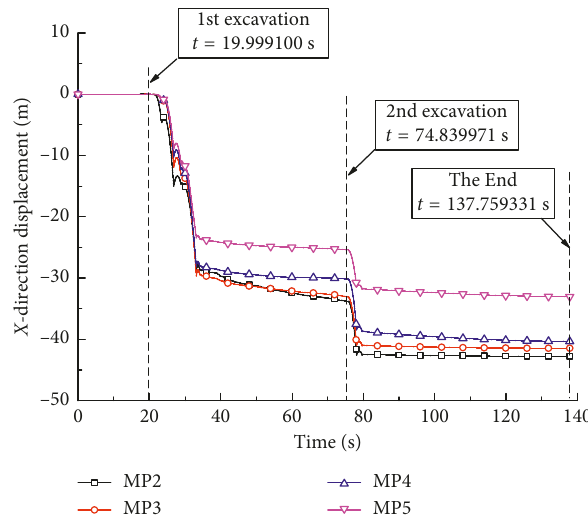
Figure 8: Horizontal displacement curves of MP2 ∼ MP5 in the J4